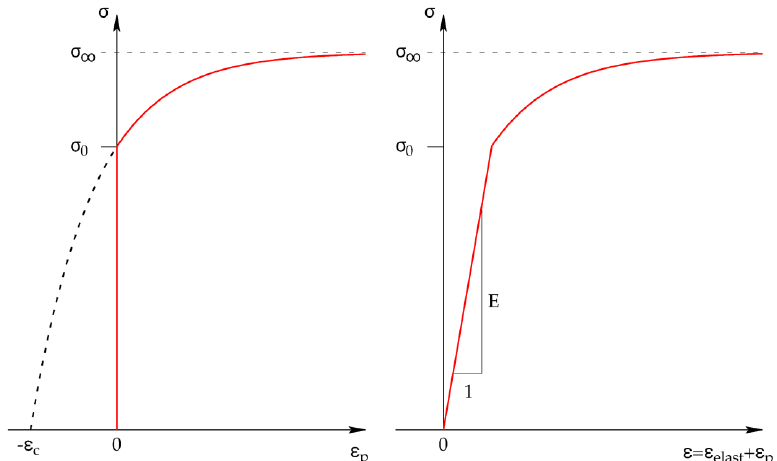
Figure A1. Interpretation of Voce’s parameters.